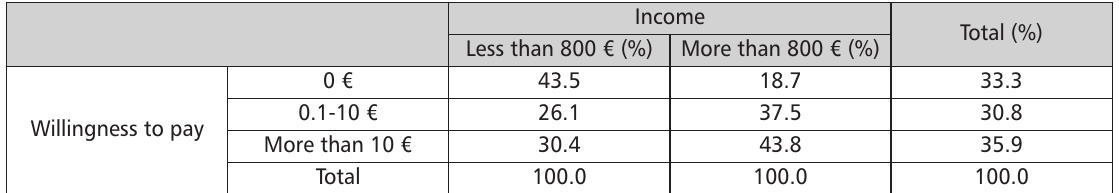
Willingness to pay for protection and management of arboretum